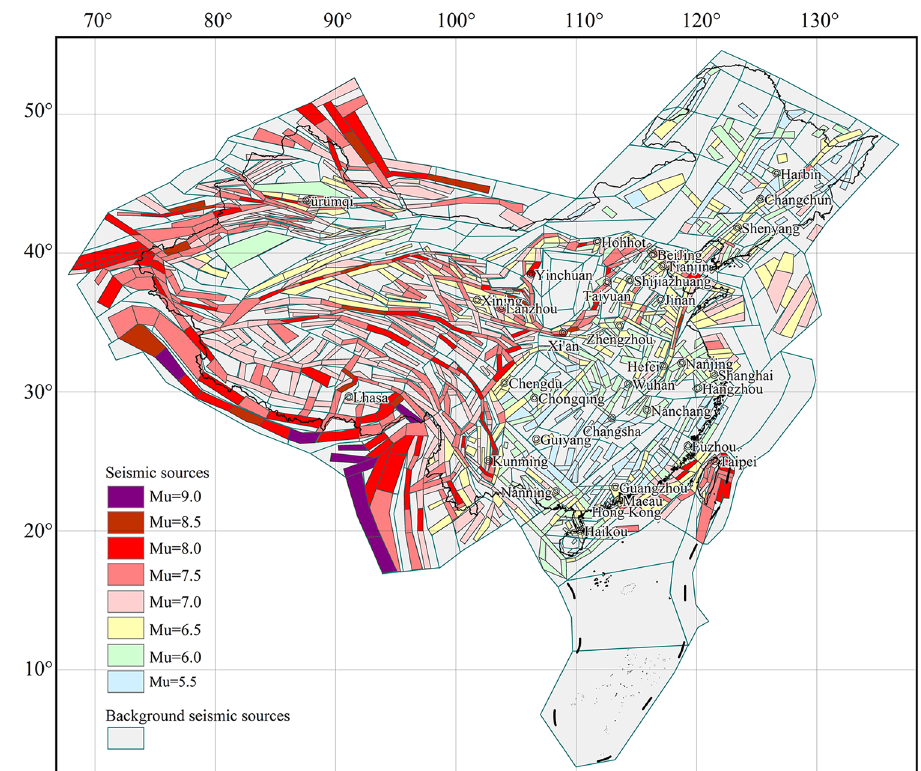
Fig. 2 Distribution of the fifth generation seismic source model in China and adjacent areas. Source WGOSHMII (2010). M u upper limit magni- tude of the seismic